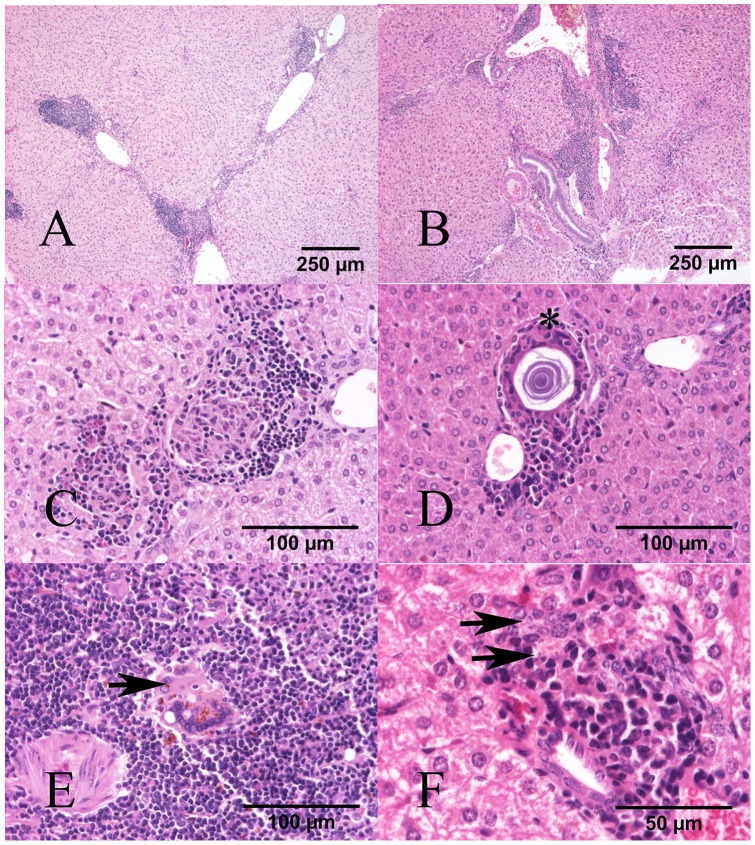
Granulomatous inflammation in liver and spleen of infected hamsters on 3% and 14% protein diets.
H–E. (A) 3%INF and (B) 14%INF: Severe, multifocal to coalescing granulomatous hepatitis. (C) Liver, 3%INF: Giant multinucleated cell containing a Shaumanns body (asterisk) within a granuloma. (D) Liver, 14%INF: two discrete granulomas containing macrophages, cell debris, epitheliod macrophages, surrounded by few lymphocytes and plasma cells. (E) Spleen, 3%INF: Giant multinucleated cell (arrow) with intracytoplasmic cell debris and hemosiderin. (F) Liver, 14%INF: Granuloma with few macrophages containing rare intracytoplasmic amastigotes (arrows).